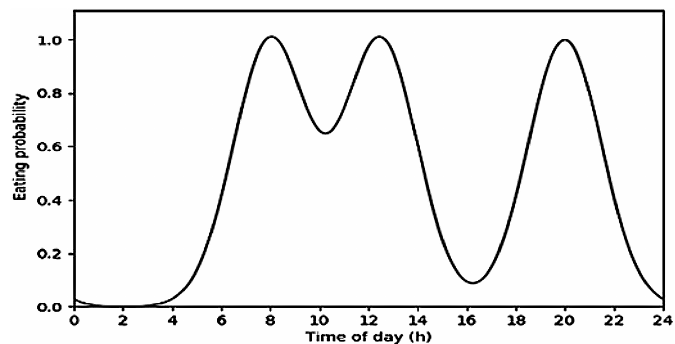
Figure 3. Estimation of the probability of having a meal by time of